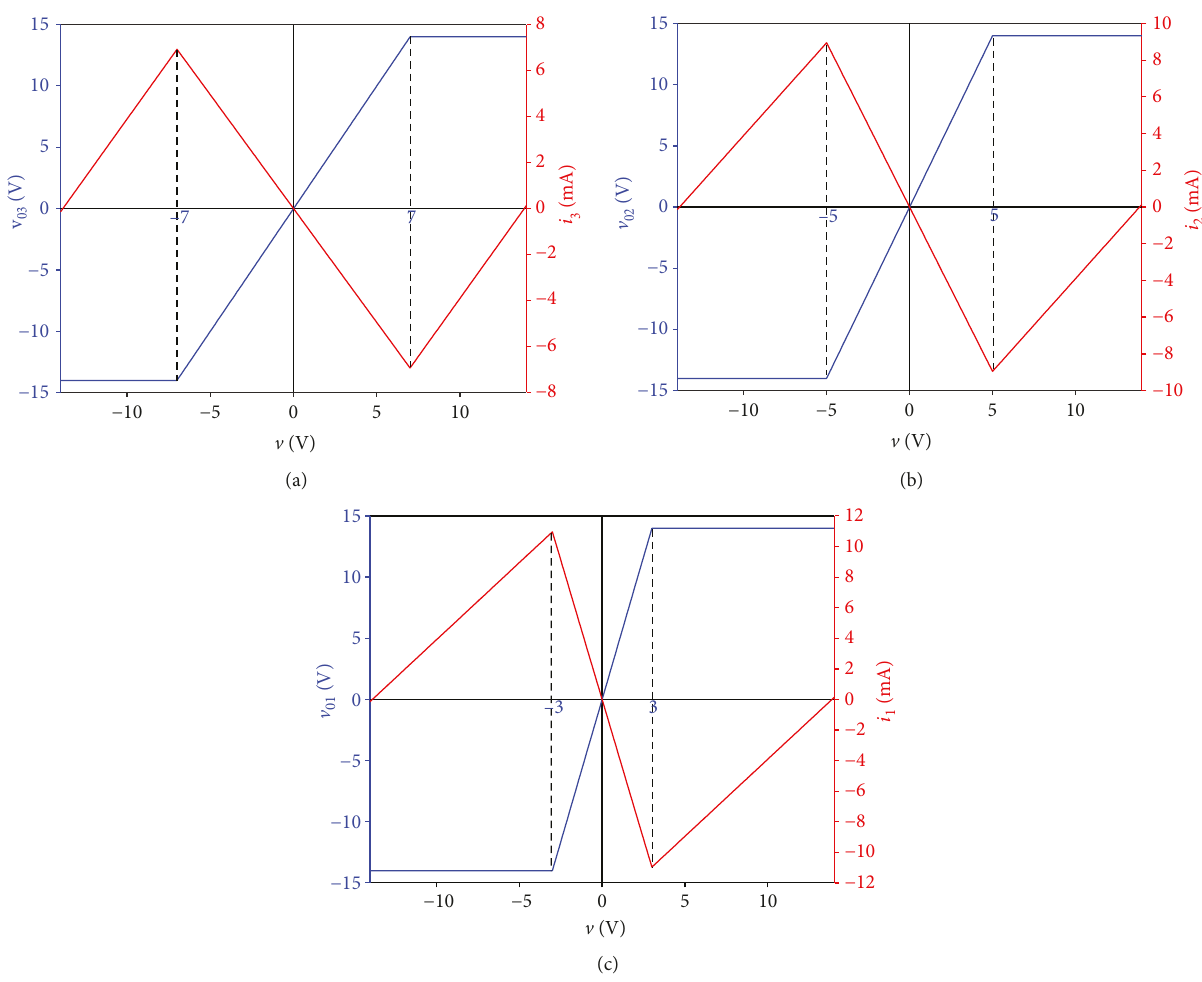
Figure 13: Mathematical simulation of input currents ( i versus v and i (a) v 03